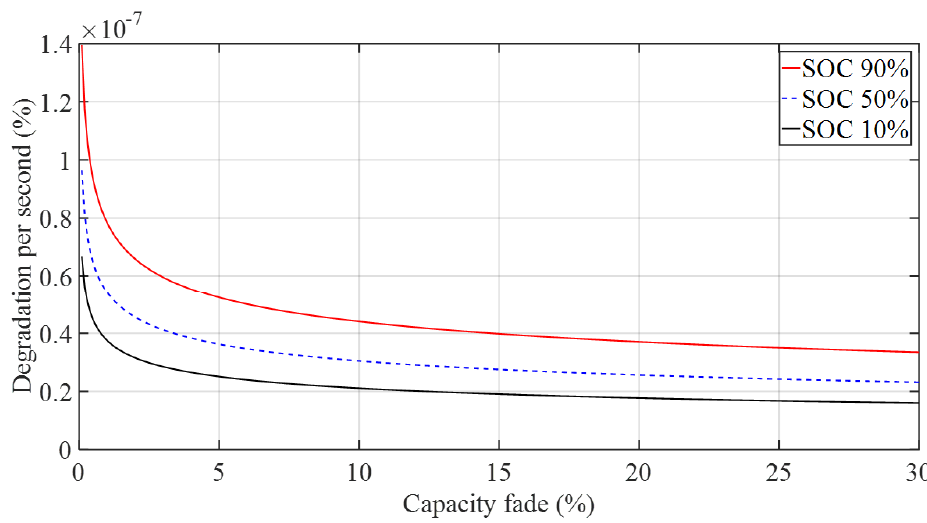
Figure 6. Model of calendar lifespan degradation during 1 s standby considering capacity fade.